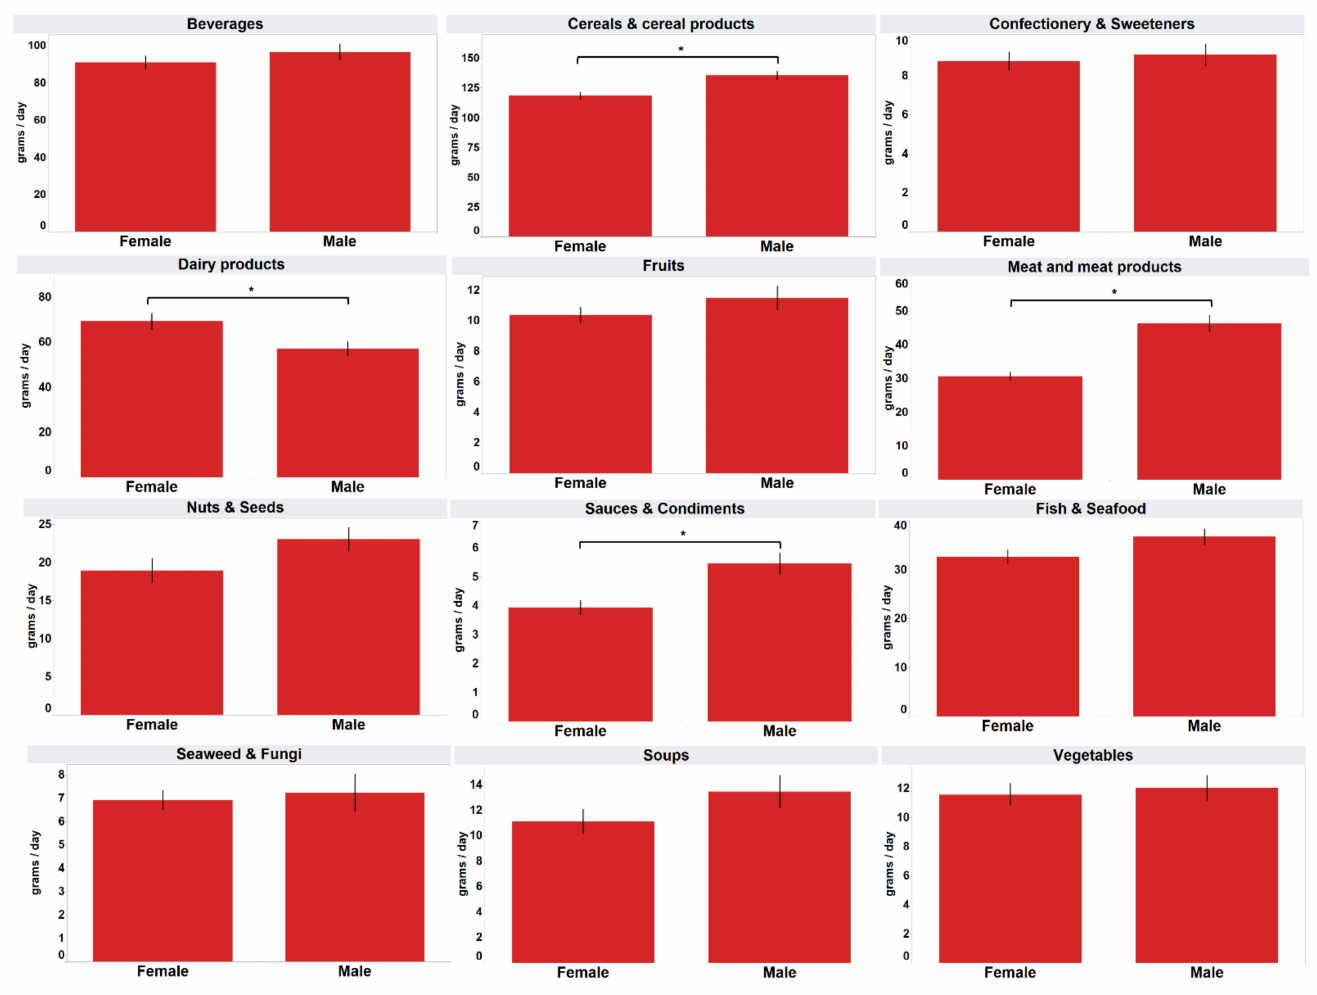
Figure 2. Mean daily intake of the consumers analysed by gender. * Mean values were significantly different as determined by independent t -tests ( p <